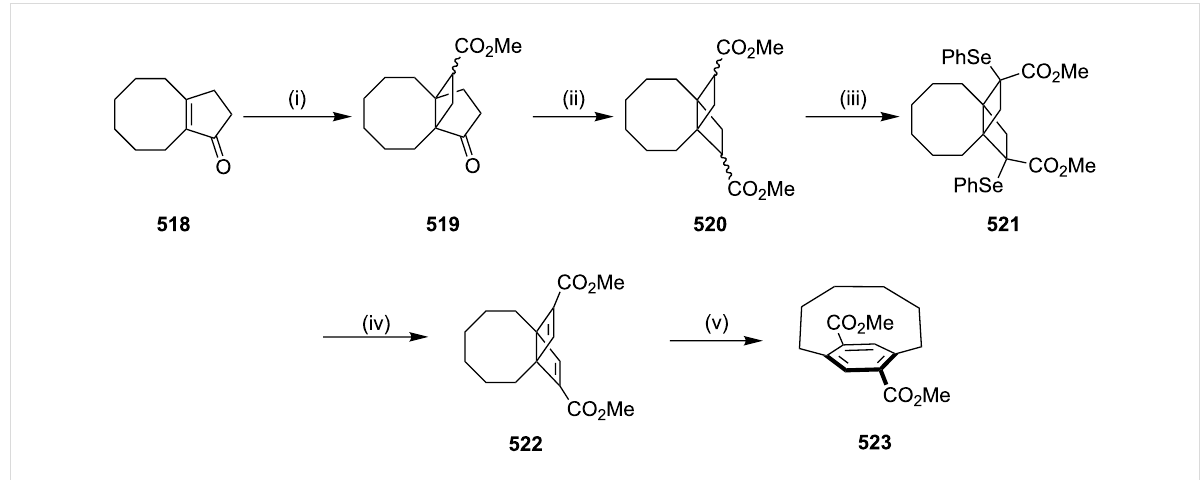
Scheme 96: Synthesis of the [6]paracyclophane via isomerization of Dewar benzene. Reagents and conditions: (i) methyl acrylate, ether, 500 W, 3–5 h, 49%; (ii) HCO 2 Me, MeONa, TsN 3 , h v, MeOH, 2 h, 35%; (iii) LDA, THF, − 78 °C, Ph 2 Se 2 , HMPA, 1 h, 32%; (iv) pyridine, CH 2 Cl 2 , H 2 O 2 , 1.5 h, 40 °C, 73%; (v) C 6 H 6 , 50 °C, 95 h, 90%.